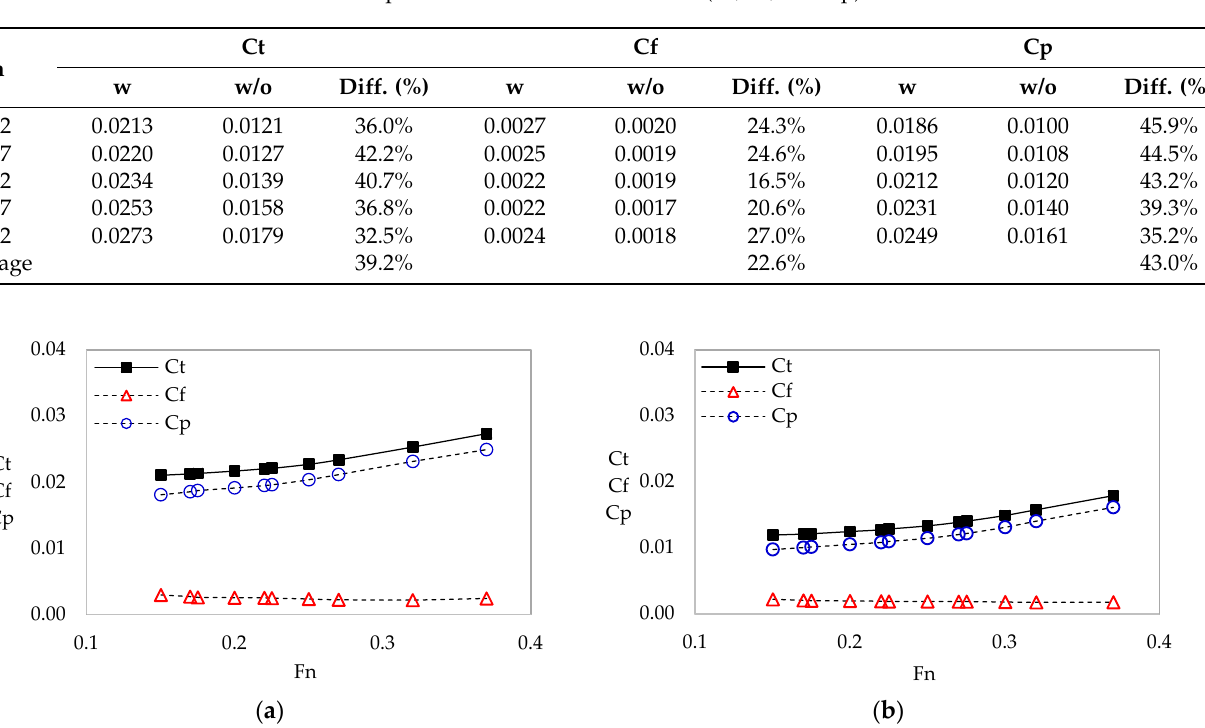
Table 4. Components of resistance coefficient (Ct, Cf, and Cp).